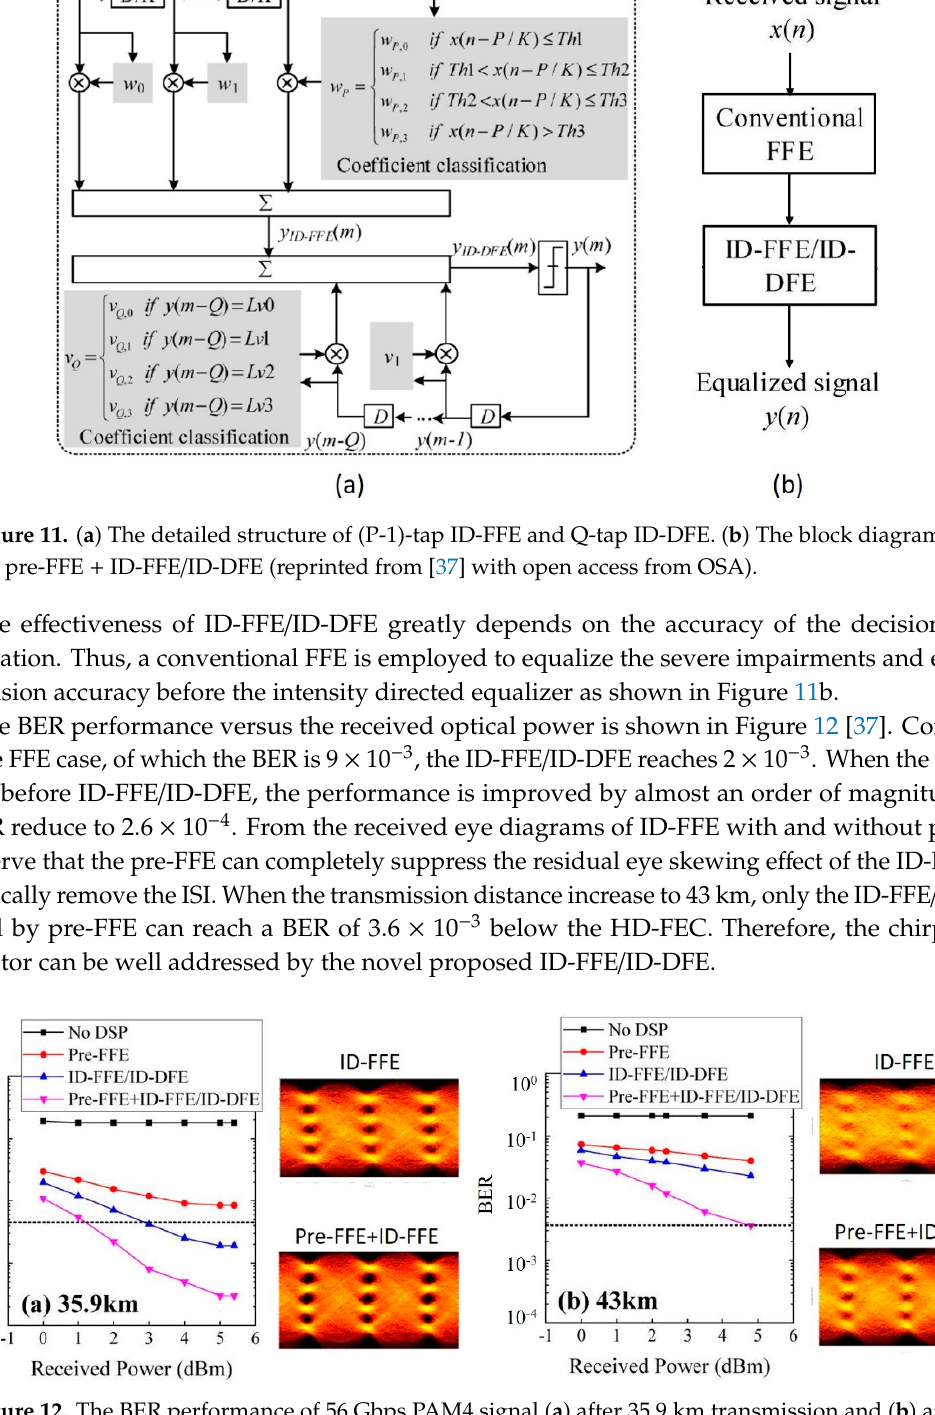
Figure 12. The BER performance of 56 Gbps PAM4 signal ( a ) after 35.9 km transmission and ( b ) after 43 km transmission (reprinted from [37] with open access from OSA).